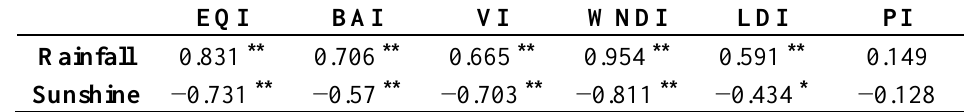
Table 2. Correlations of EQI with rainfall,